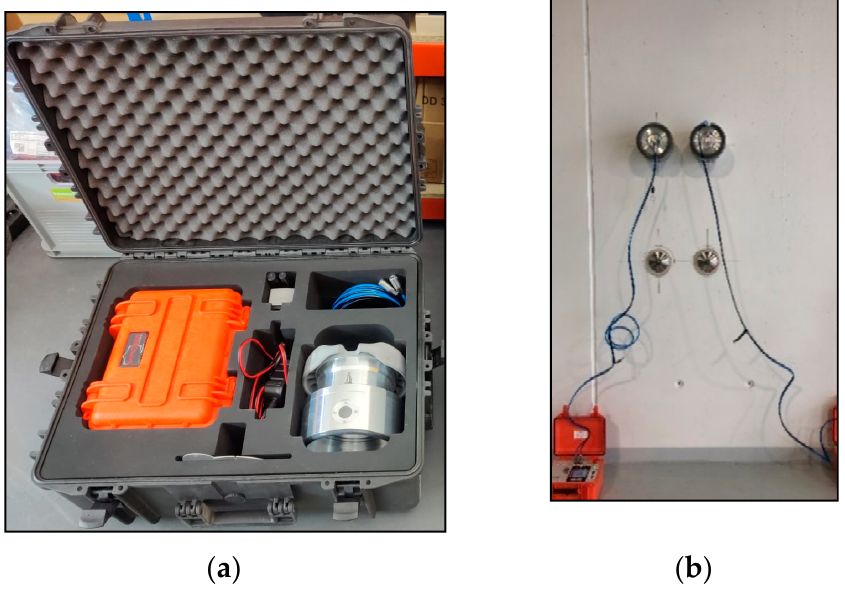
Figure 3. ( a ) Tooling for the installation of C-BLOCK fastener; ( b ) on-going installation cycle. Concrete slabs dimensions were 1440 mm × 500 mm × 330 mm. Four longitudinal M20 bars were used as reinforcement for tests in cracked and non-cracked concrete (Figure 4). Threaded rods were in class 8.8 according to EN ISO 898-1 [4]. The longitudinal